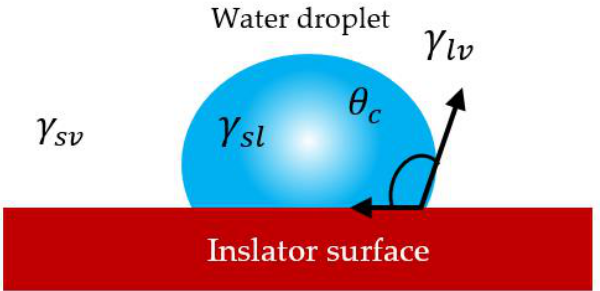
Figure 3. Interfacial surface tensions and the contact angle